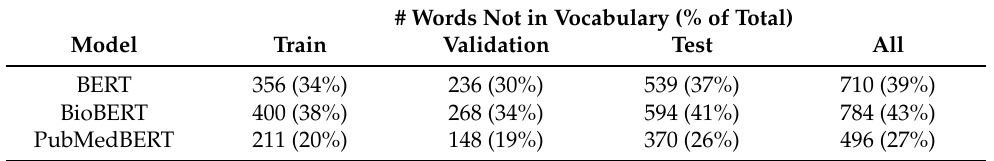
Table 5. Comparison of BERT, BioBERT and PubMedBERT unknown vocabulary in our